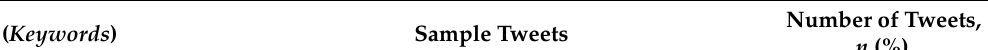
Table 1. Themes related to the negative public perception of COVID-19 vaccination, along with the respective topics and sample tweets ( n =